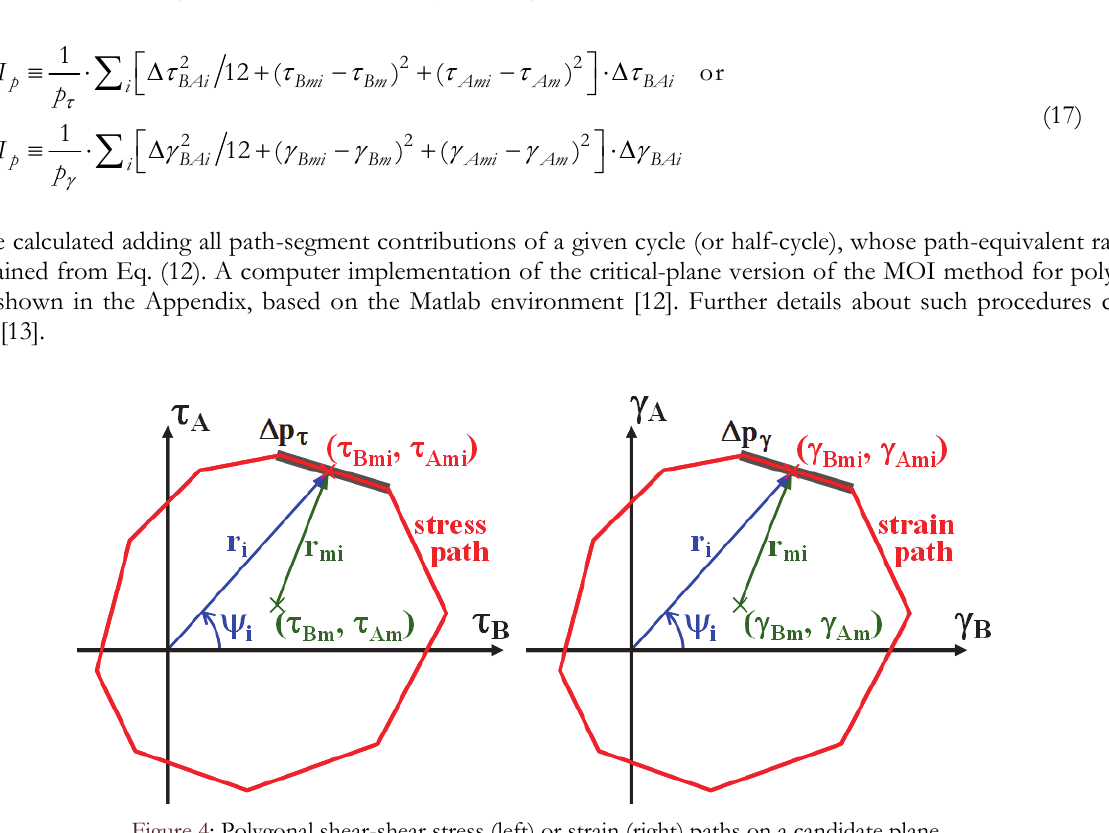
Figure 4: Polygonal shear-shear stress (left) or strain (right) paths on a candidate